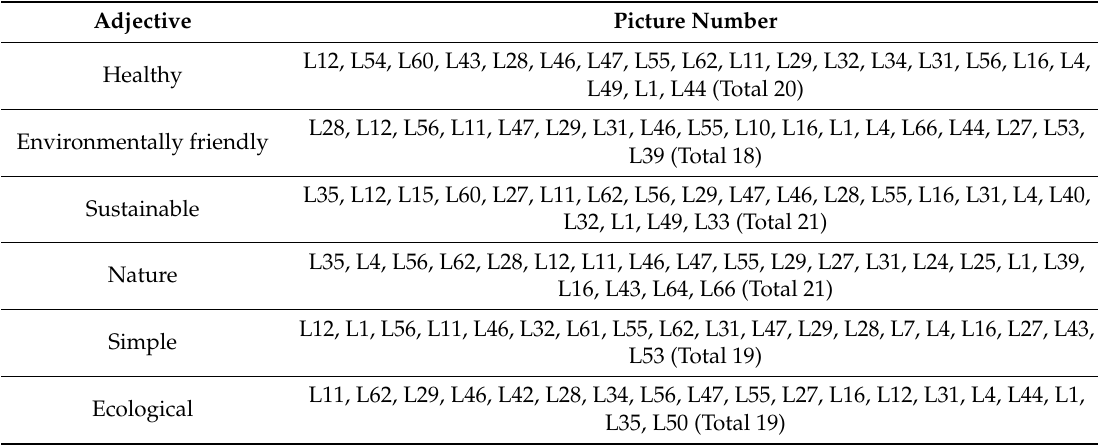
Table 2. Recommend pictures for individual image